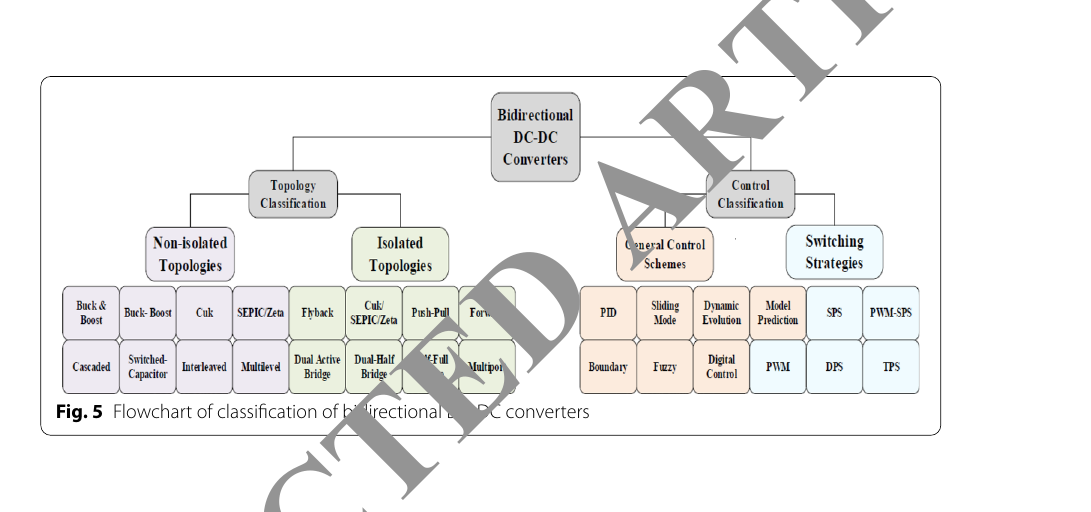
Fig. 5 Flowchart of classification of bidirectional DC-DC